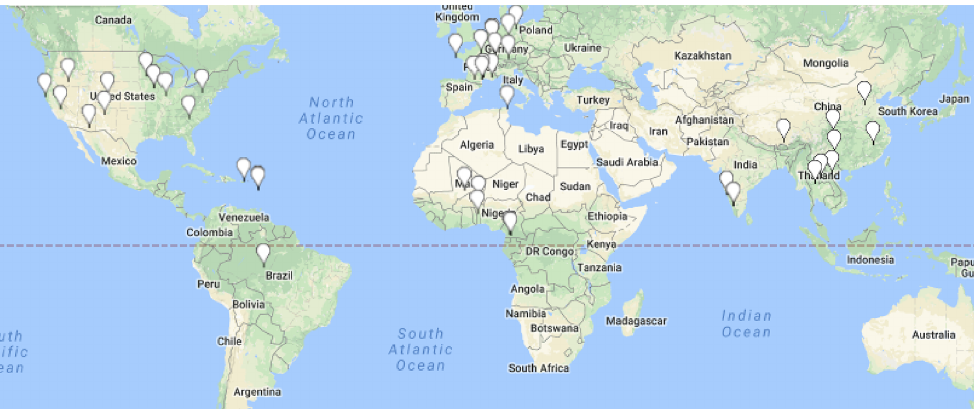
Figure 3. Location map of the 45 CZO locations in the United States, Germany (TERENO), France (RBV/CRITEX), UK, and China that have been registered on Site Seeker (http://www.czen.org/site_seeker). The sites in South America, Africa, India, and several in the Caribbean are operated by the French RBV/CRITEX